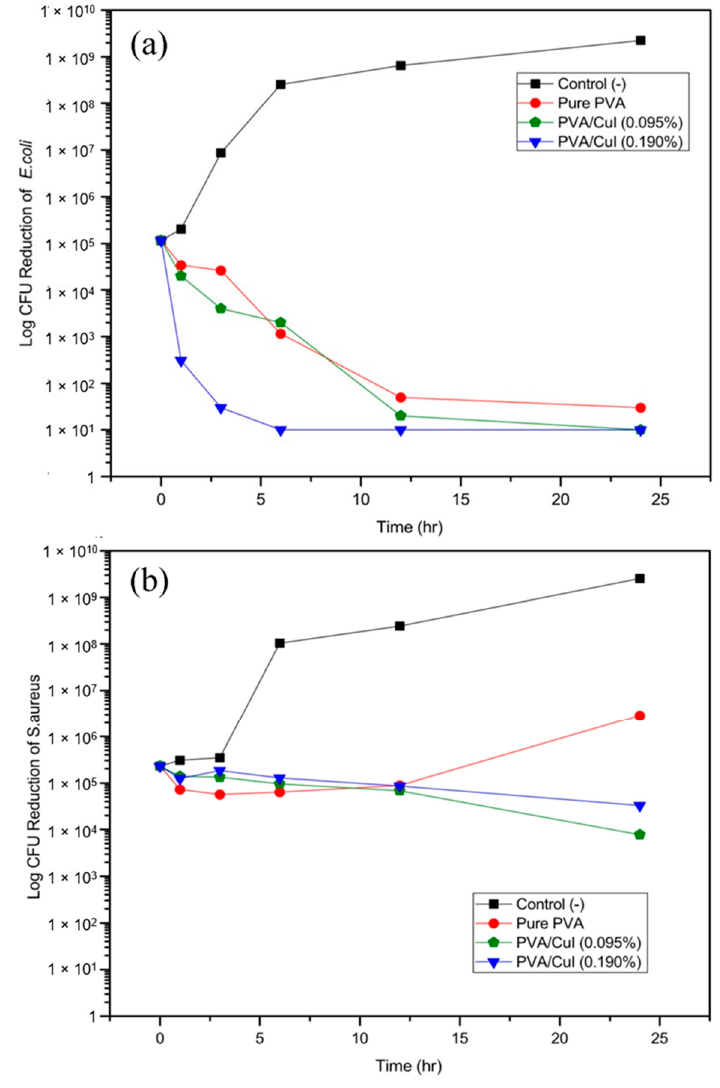
Figure 15. Bacterial reduction of E. coli ( a ) and MRSA ( b ) after incubation in liquid bandage.